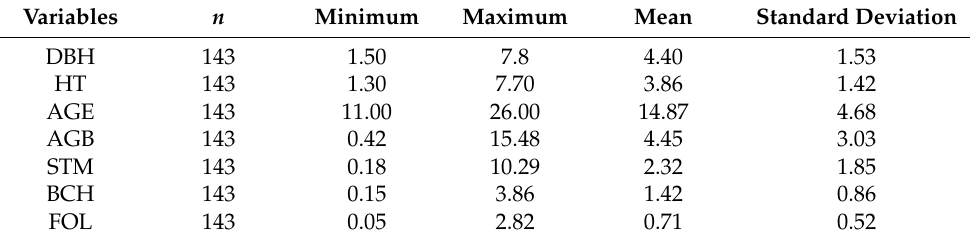
Table 1. Summary statistics of sample trees used in estimating total aboveground biomass and its components. Variables n